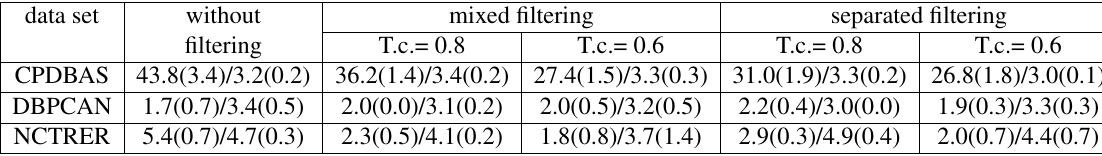
Table 3: Complexity of the constructed models. In each cell the left-hand-side numbers repre- sent average number of rules (clauses) and its standard deviation (in parenthesis) and on the right hand-side the average number of conditions (clause length) and its standard deviation (in paren- thesis). T.c. is the Tanimoto